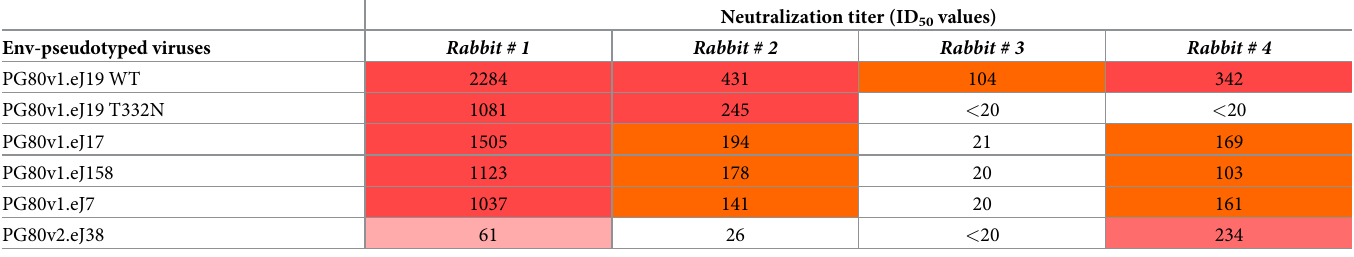
Table 1. Neutralization of sequence matched and unmatched autologous Env-pseudotyped viruses by serum antibodies obtained from 1PGE-THIVC immunized rabbits.